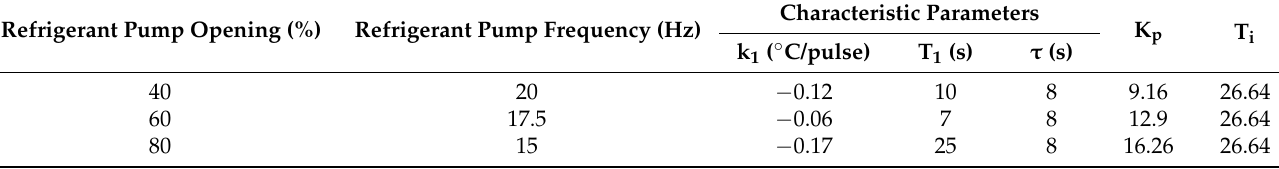
Table 5. Parameters under different